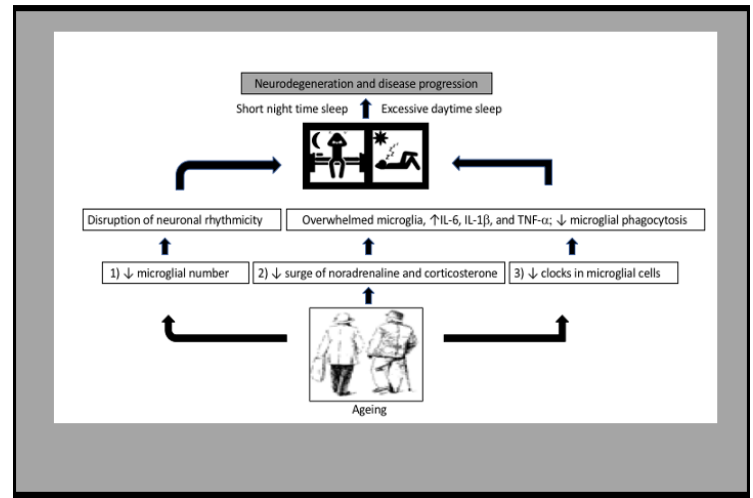
Figure 4. Schematic of microglial contribution in poor-quality sleep in the elderly: (1) the marked decline in microglia disrupts the circadian system of neuronal activity. (2) Decreased concentrations of noradrenaline and corticosterone affect microglial homeostasis. (3) The abnormal rhythmic pattern and/or decreased expression of clock genes drive microglia toward the inflammatory phenotype. The consequences of these three events in microglial cells ultimately affect sleep patterns by altering cellular rhythmic function and increasing proinflammatory cytokine release in aging.